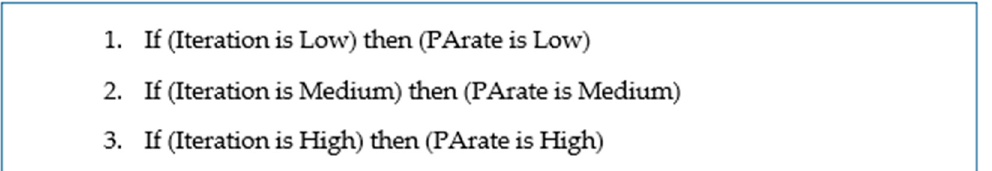
Figure 10. Rules for Fuzzy System 2 to Increase (FHS2).